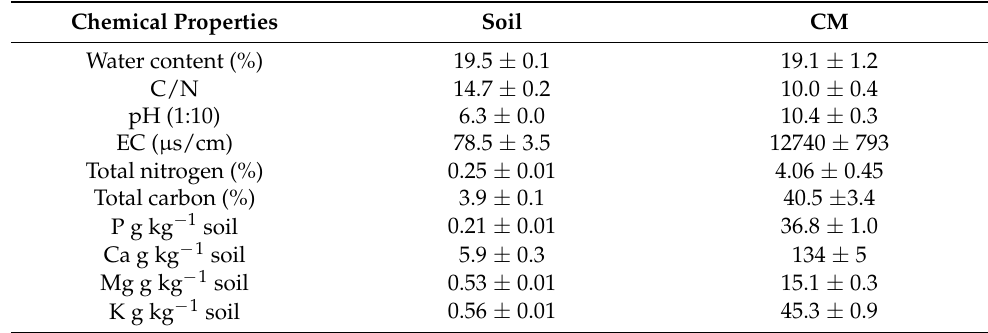
Table 1. Chemical properties of soil and carbonized chicken manure